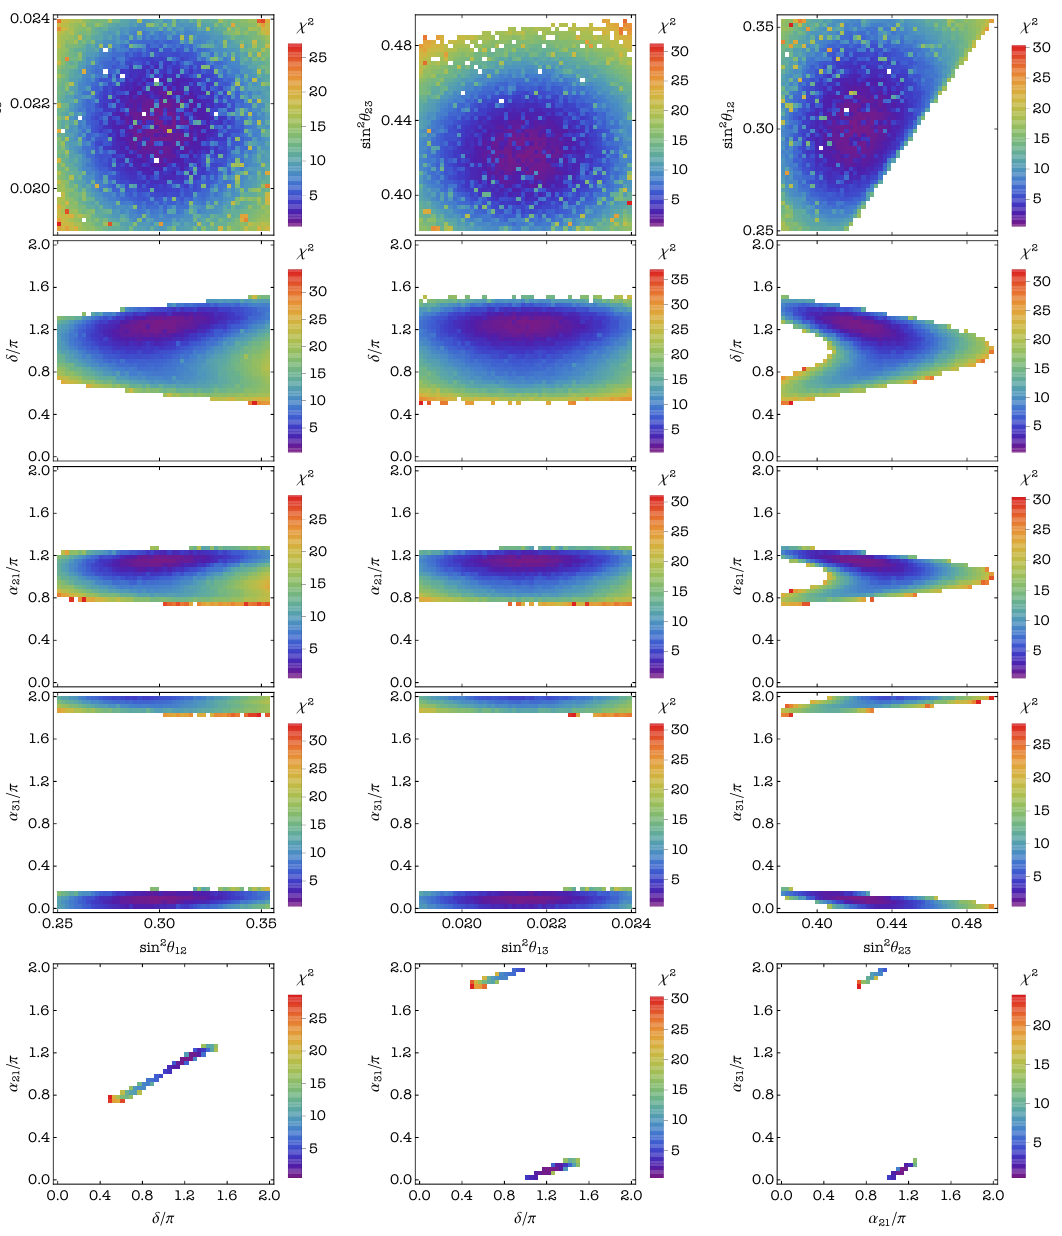
Figure 9 . Correlations between the neutrino mixing parameters in case C5. The values of all the three mixing angles are required to lie in their respective 3 (cid:27) ranges. Colour represents values of (cid:31) 2 for the NO neutrino mass spectrum.